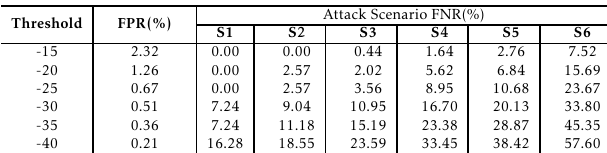
Table 5. Experimental results for the HsMM for the attack strategy of focusing on high cost requests.